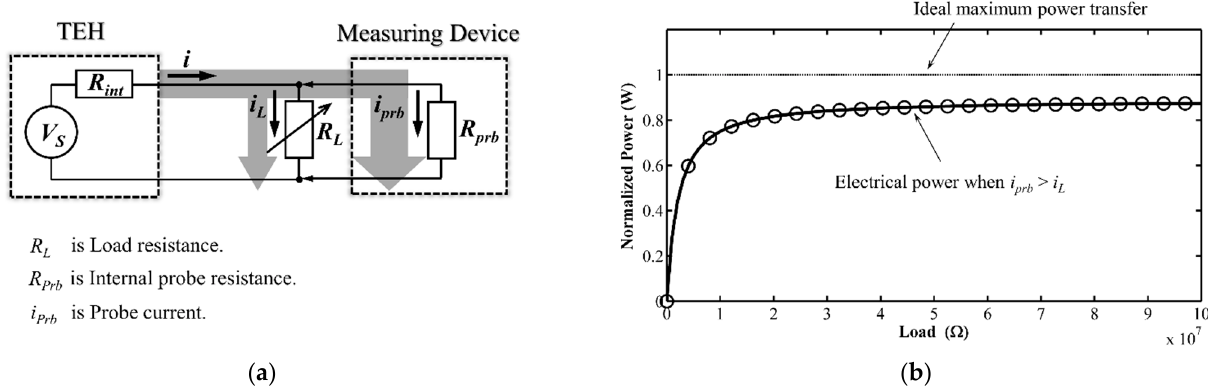
Figure 1. ( a ) Schematic diagram of the conventional measuring technique and ( b ) plot of maximum power versus load resistance under this technique. Table 1. Internal resistance of several existing triboelectric energy harvesters.